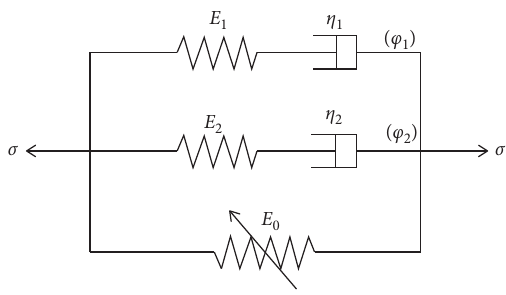
Figure 3: Z–W–T constitutive